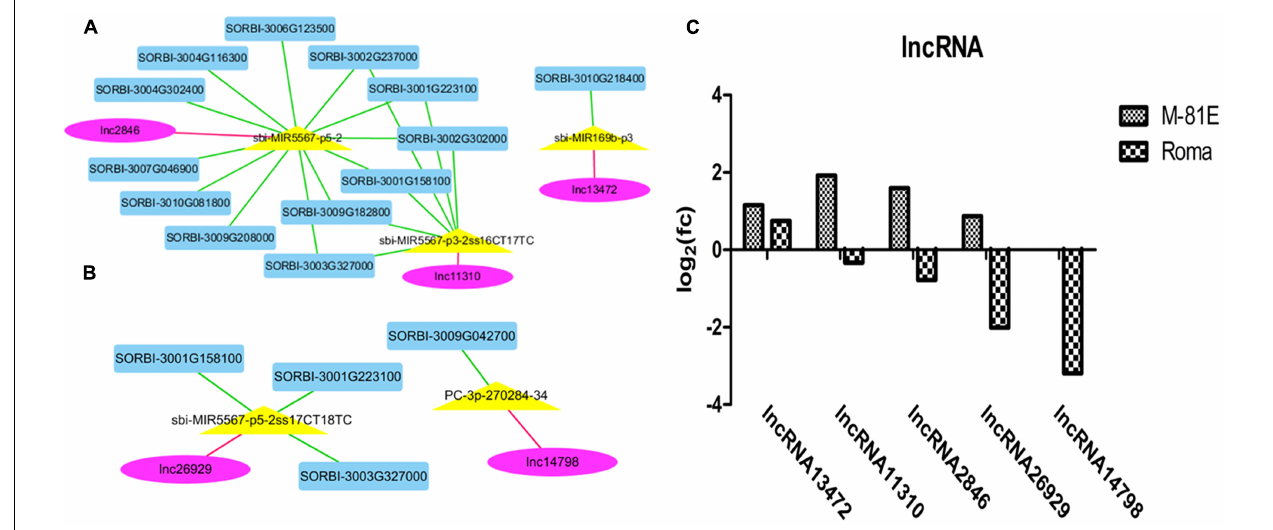
FIGURE 4 | A ceRNA network enriched in salt response pathways in M-81E (A) and Roma (B) . Pink, yellow, and blue nodes represent lncRNAs, miRNAs, and mRNAs, respectively. Green edges represent miRNA-target interactions, while pink edges represent a competitive relationship. (C) Expression level of five unknown lncRNAs in M-81E and